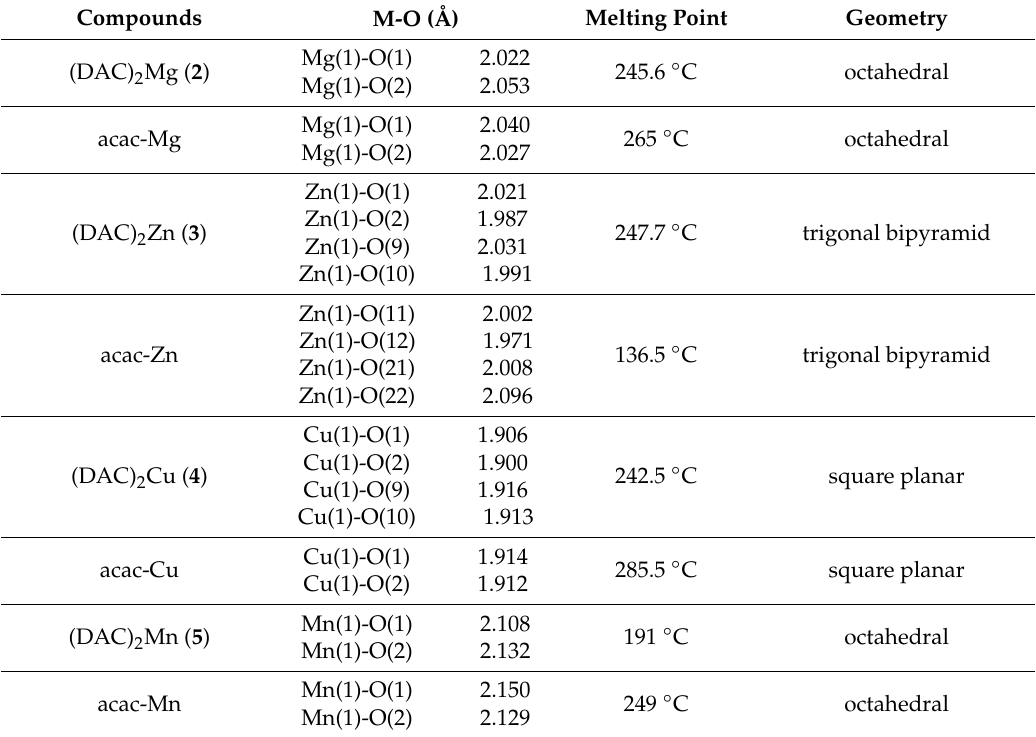
Table7. Comparisonofbonddistances(Å)ofmetalcomplexesofdiacetylcurcuminandacetylacetonates.